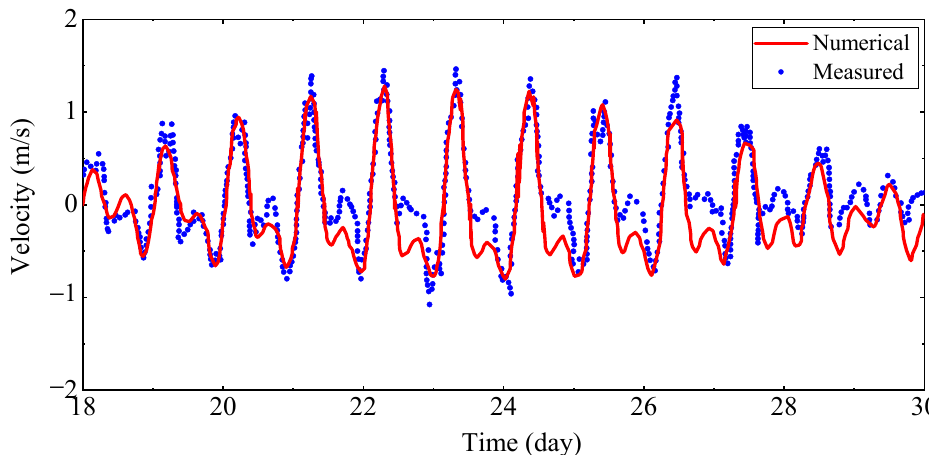
Figure 3. Comparisons of depth-averaged velocity between simulated and measured values at location L1 in June 2005.